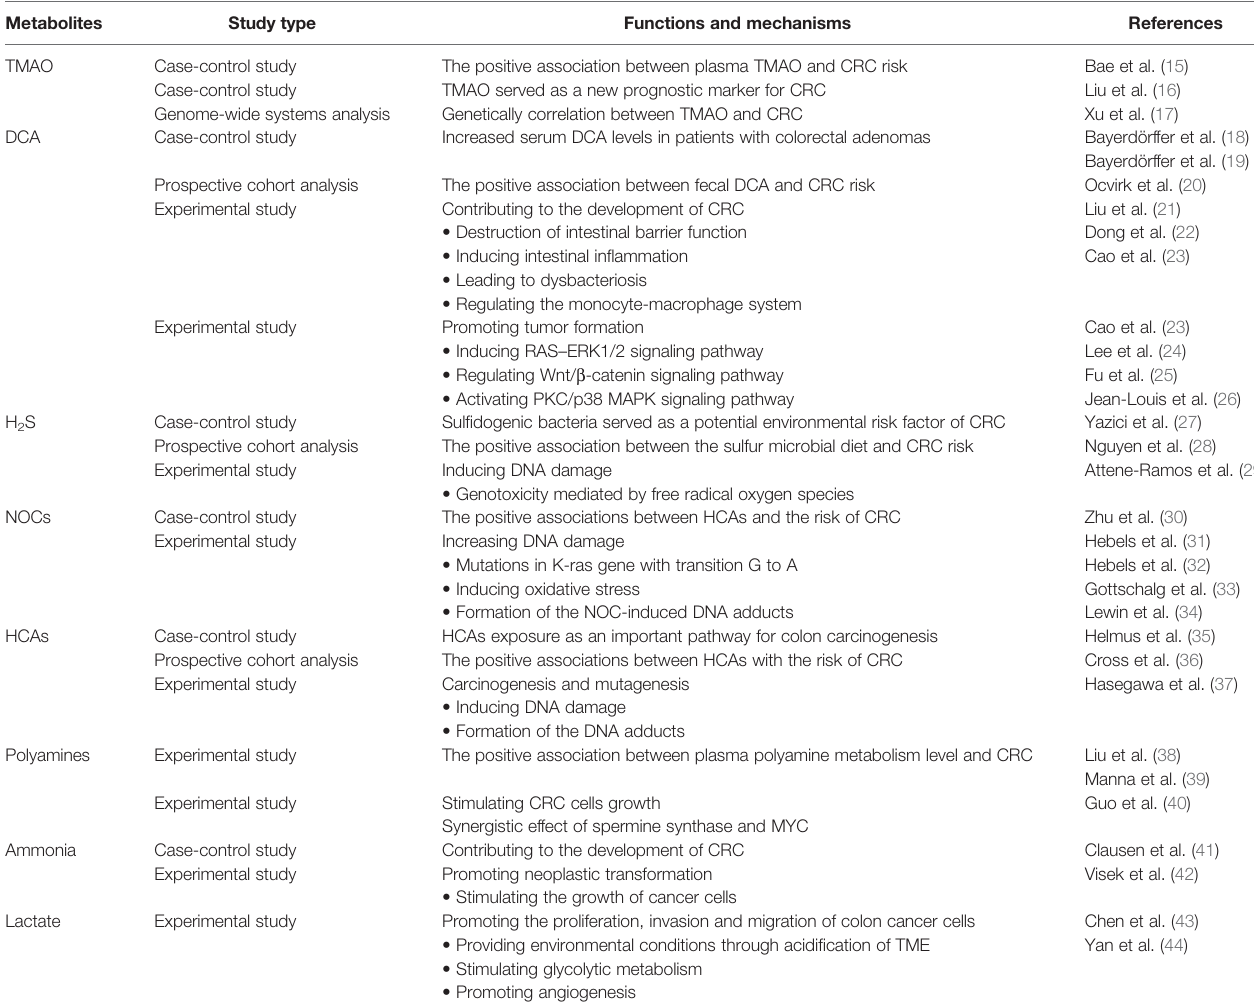
TABLE 2 | Summary of studies related to detrimental microbiota-derived metabolites involved in